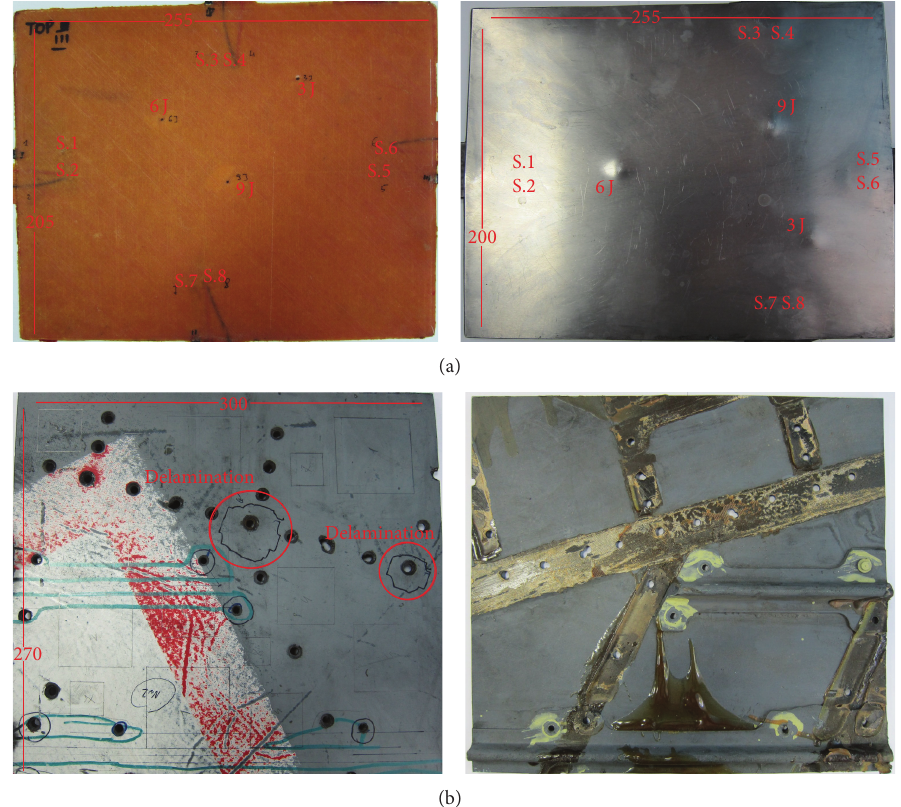
Figure 6: GFRP, Al-GFRP-Al, and CFRP extraction from the vertical stabilizer of the aircraft (a and b).